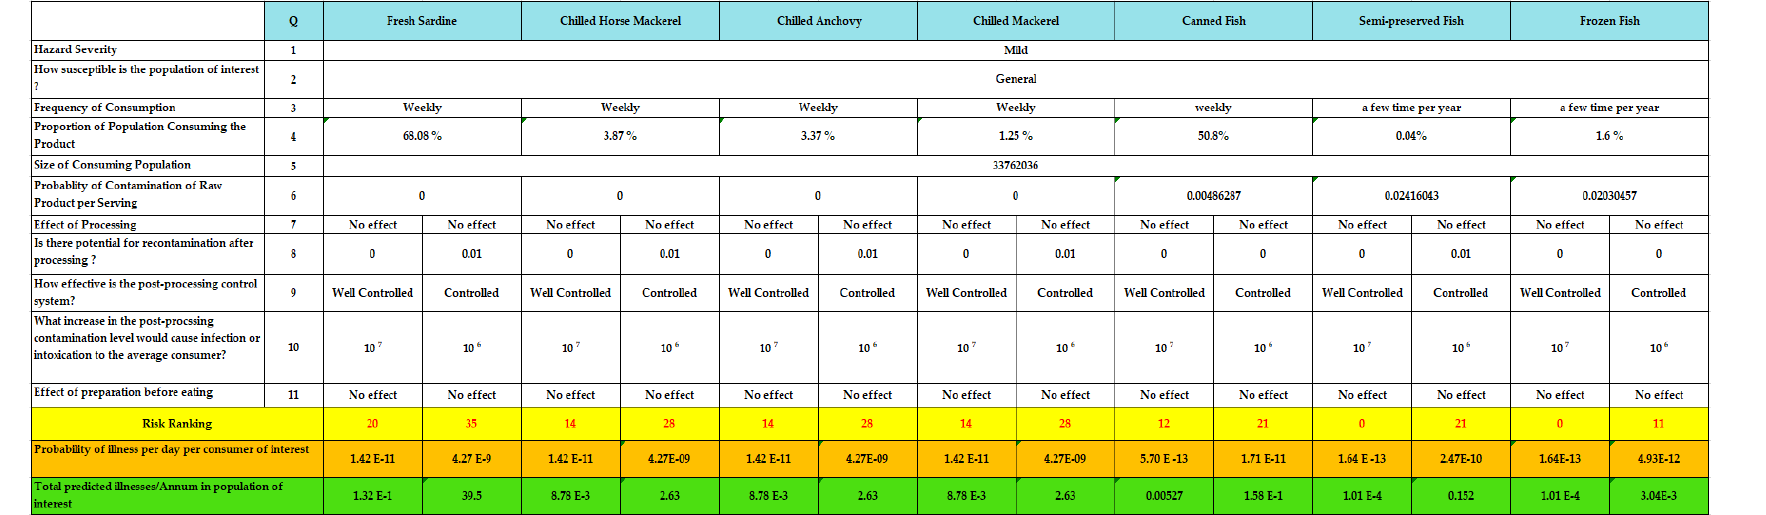
Figure 4. Summary of Risk Ranger applications for different categories of fishery